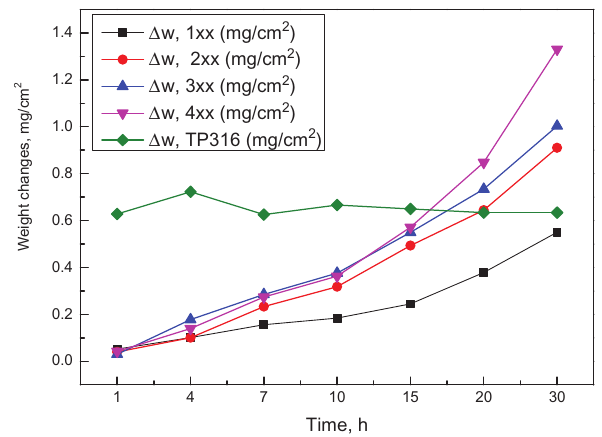
Figure 2: Weight changes during the corrosion process in KCl for four test materials and reference TP316 at 600°C.